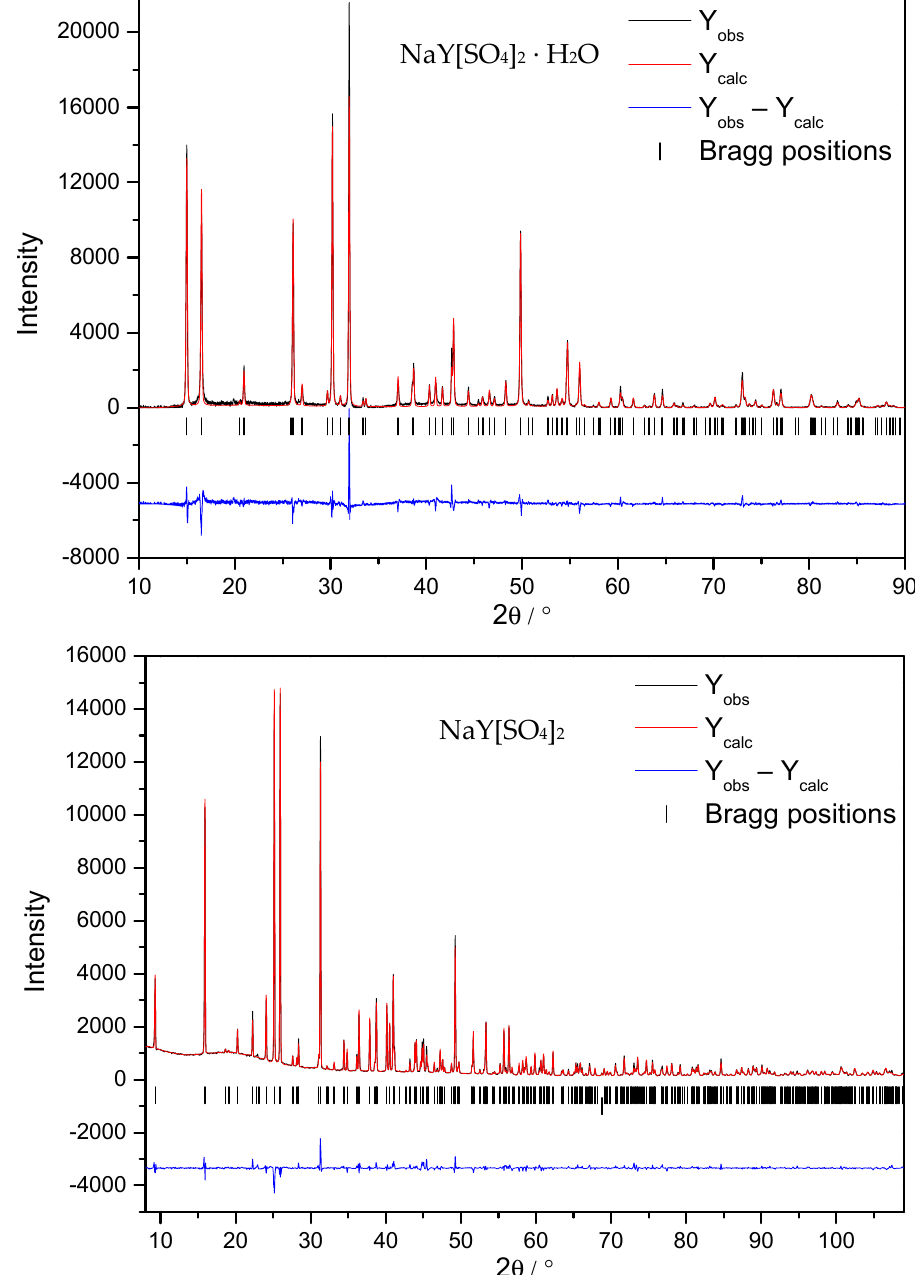
Figure 2. Rietveld refinement based on PXRD data of NaY[SO 4 ] 2 · H 2 O ( top ) for checking its phase purity and NaY[SO 4 ] 2 ( bottom ) for crystal-structure determination and refinement.